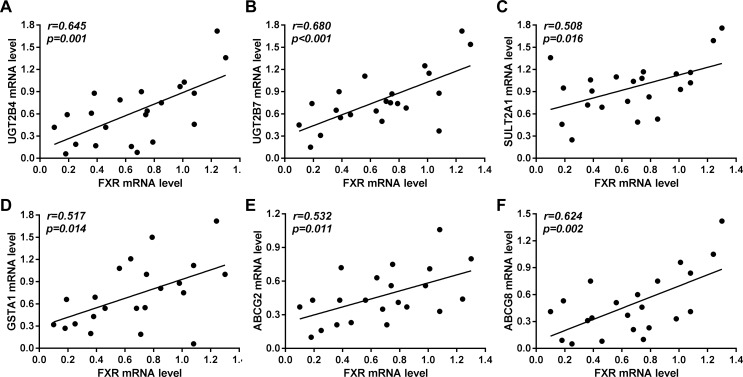
Correlation of the mRNA levels of the nuclear receptor, FXR, with the mRNA levels of detoxification enzymes and canalicular membrane transporters in human obstructive cholestatic livers.The mRNA levels of bile acid receptor FXR and detoxification enzymes (A) UGT2B4, (B) UGT2B7, (C) SULT2A1, (D) GSTA1, and canalicular membrane transporters (E) ABCG2, and (F) ABCG8 in the livers of patients with obstructive cholestasis due to gallstone biliary obstruction (n = 22). The data were analyzed by the Pearson’s correlation test using GraphPad Prism 6.01. r, Pearson correlation. A value of p < 0.05 was considered to be statistically significant.